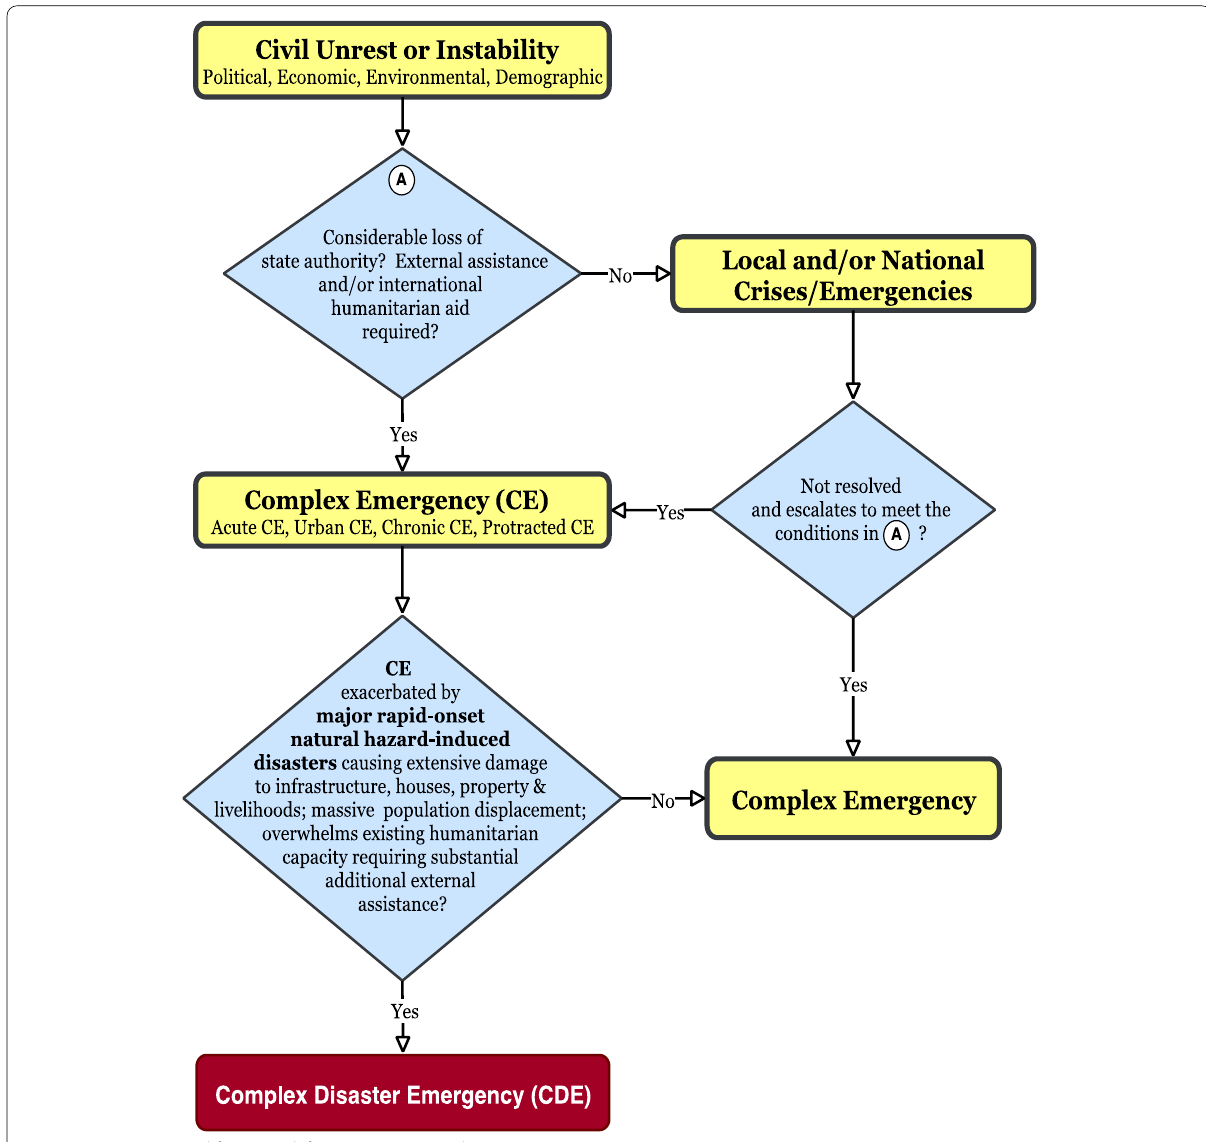
Fig. 5 New conceptual framework for CDE. Source: